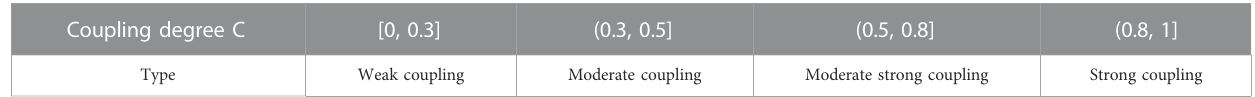
TABLE 2 The classi fi cation of coupling